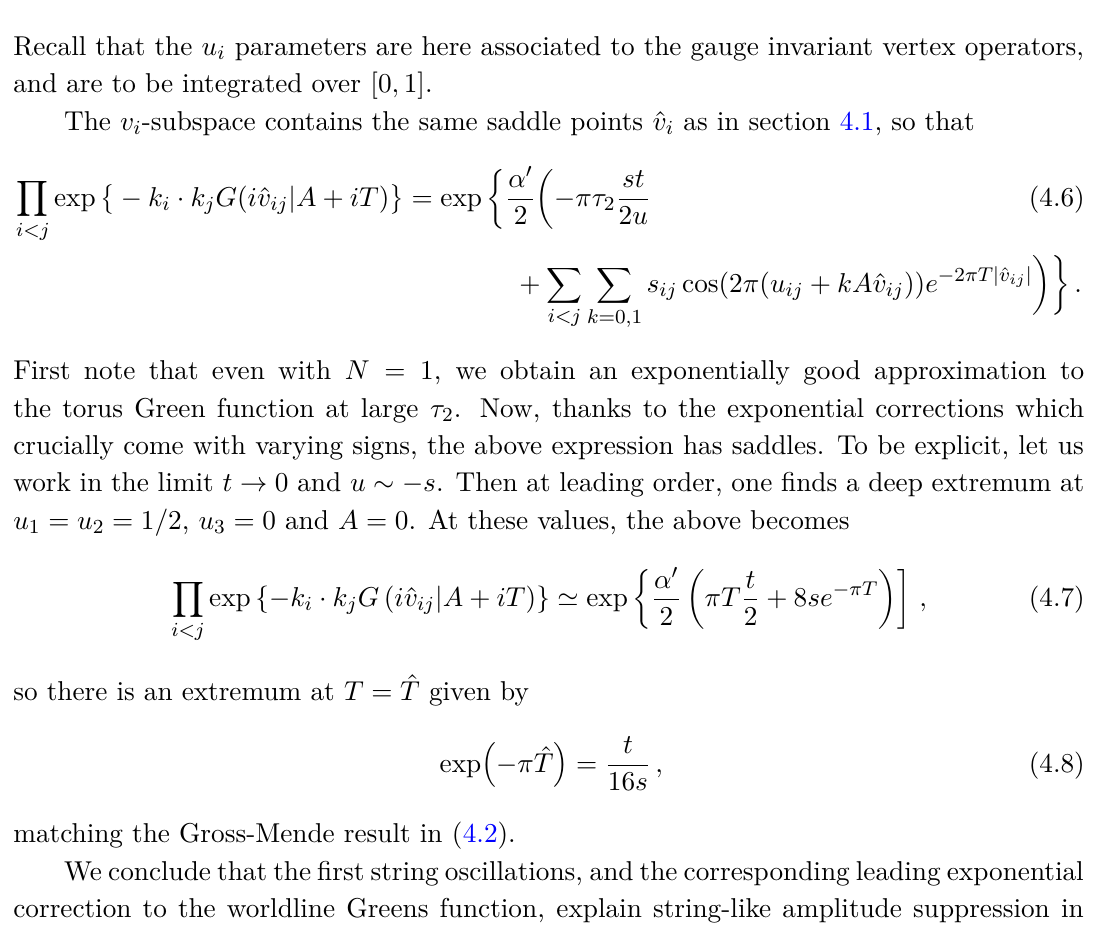
Figure 1 . Congruence subgroup Γ 0 (2) , a subset of the complex plane. The Gross-Mende saddle is mapped under cycling s , t and u to copies of the SL(2 , Z ) fundamental domain as